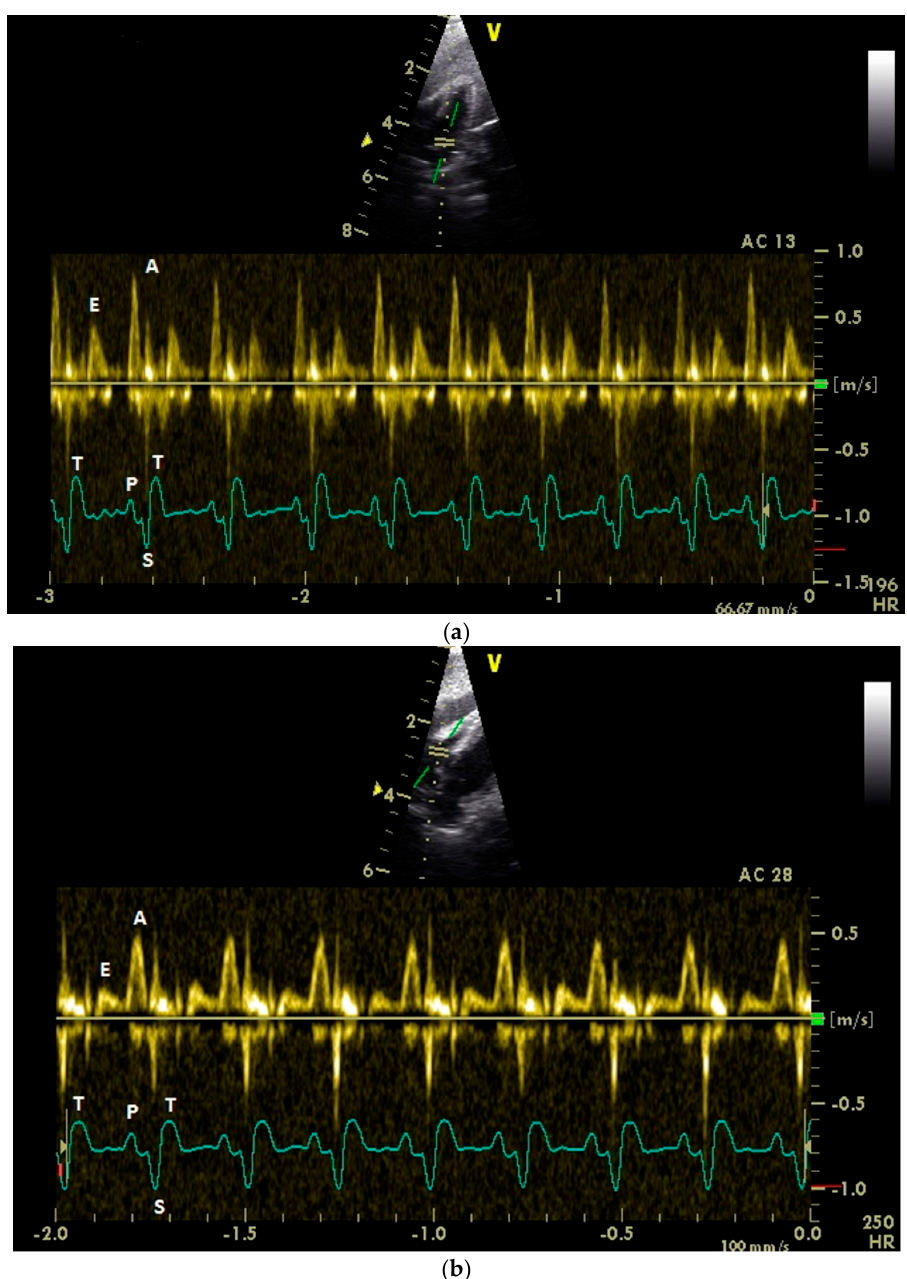
Figure 1. Pulsed-wave Doppler echocardiographic images of a conscious healthy racing pigeon of the left ( a ) and the right ( b ) atrioventricular blood flow using right parasternal approach. Diastolic blood flow: E: early passive ventricular filling; A: active ventricular filling. Electrocardiogram: P: P wave; S: S wave; and T: T wave.